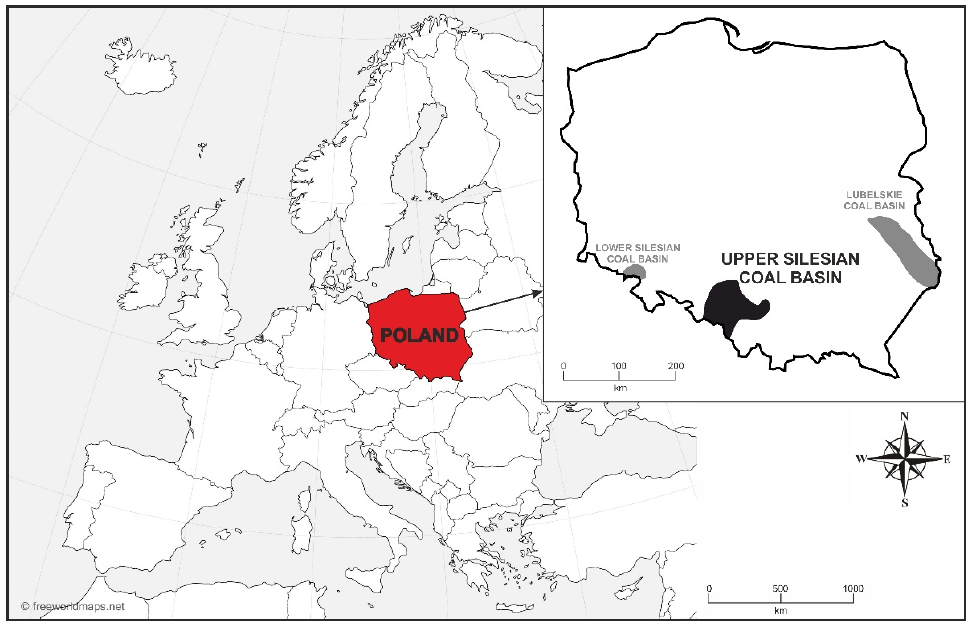
Figure 1. Location of USCB in Poland.